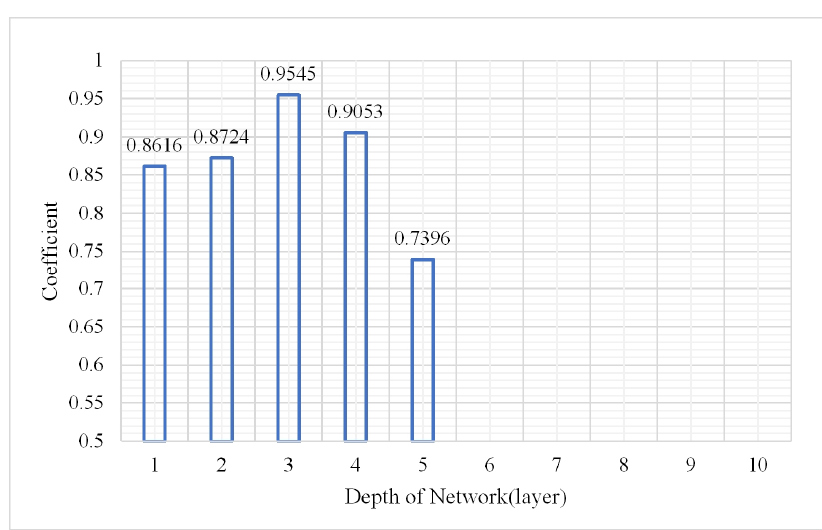
Figure 4. Change in overall accuracy.